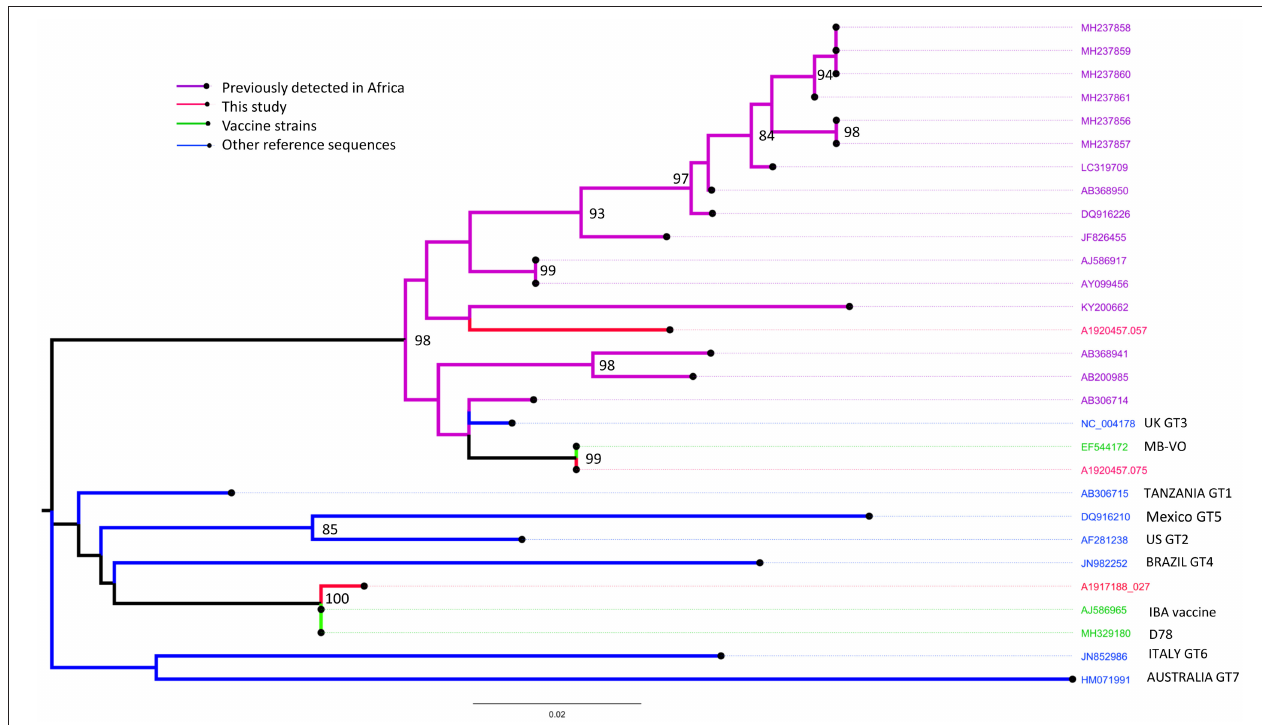
FIGURE 4 | Maximum likelihood phylogenetic tree of a 394 nucleotide region of 29 sequences showing the relationships between the IBDV isolates obtained from Farms 1 (sample ref: A1920457.057), 19 (A1920457.075) and 35 (A1917188.027) for the VP2 gene implemented in MEGA-X. Study sequences are shown in red. Bootstrap values (percentage of 500) over 85 are shown. GT: genotype (GT1, classical pathotype; GT2, antigenic variant; GT3, vvIBDV; GT4, dIBDV; GT5, variant/classical recombinant; GT6, Italy; GT7,